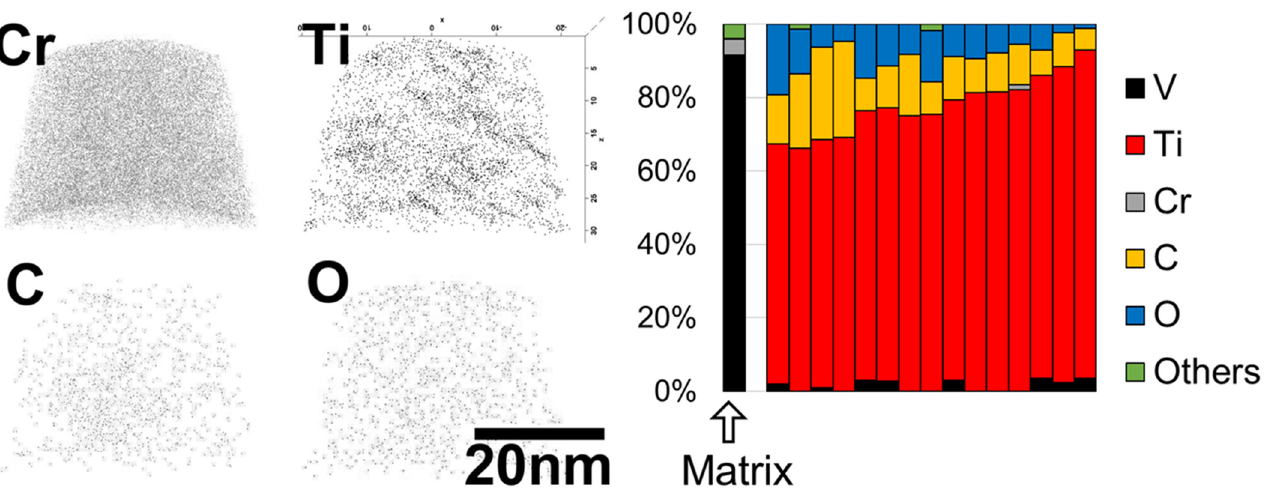
Figure 6. APT measurement in He-irradiated V–4Cr–1Ti alloy at 500 °C with a conventional impurity level. The left section shows atom maps in an irradiated sample. The right section shows the ratio of atom concentrations inside each Ti aggregate by APT measurement. Data on the left end shows the chemical composition in the matrix.